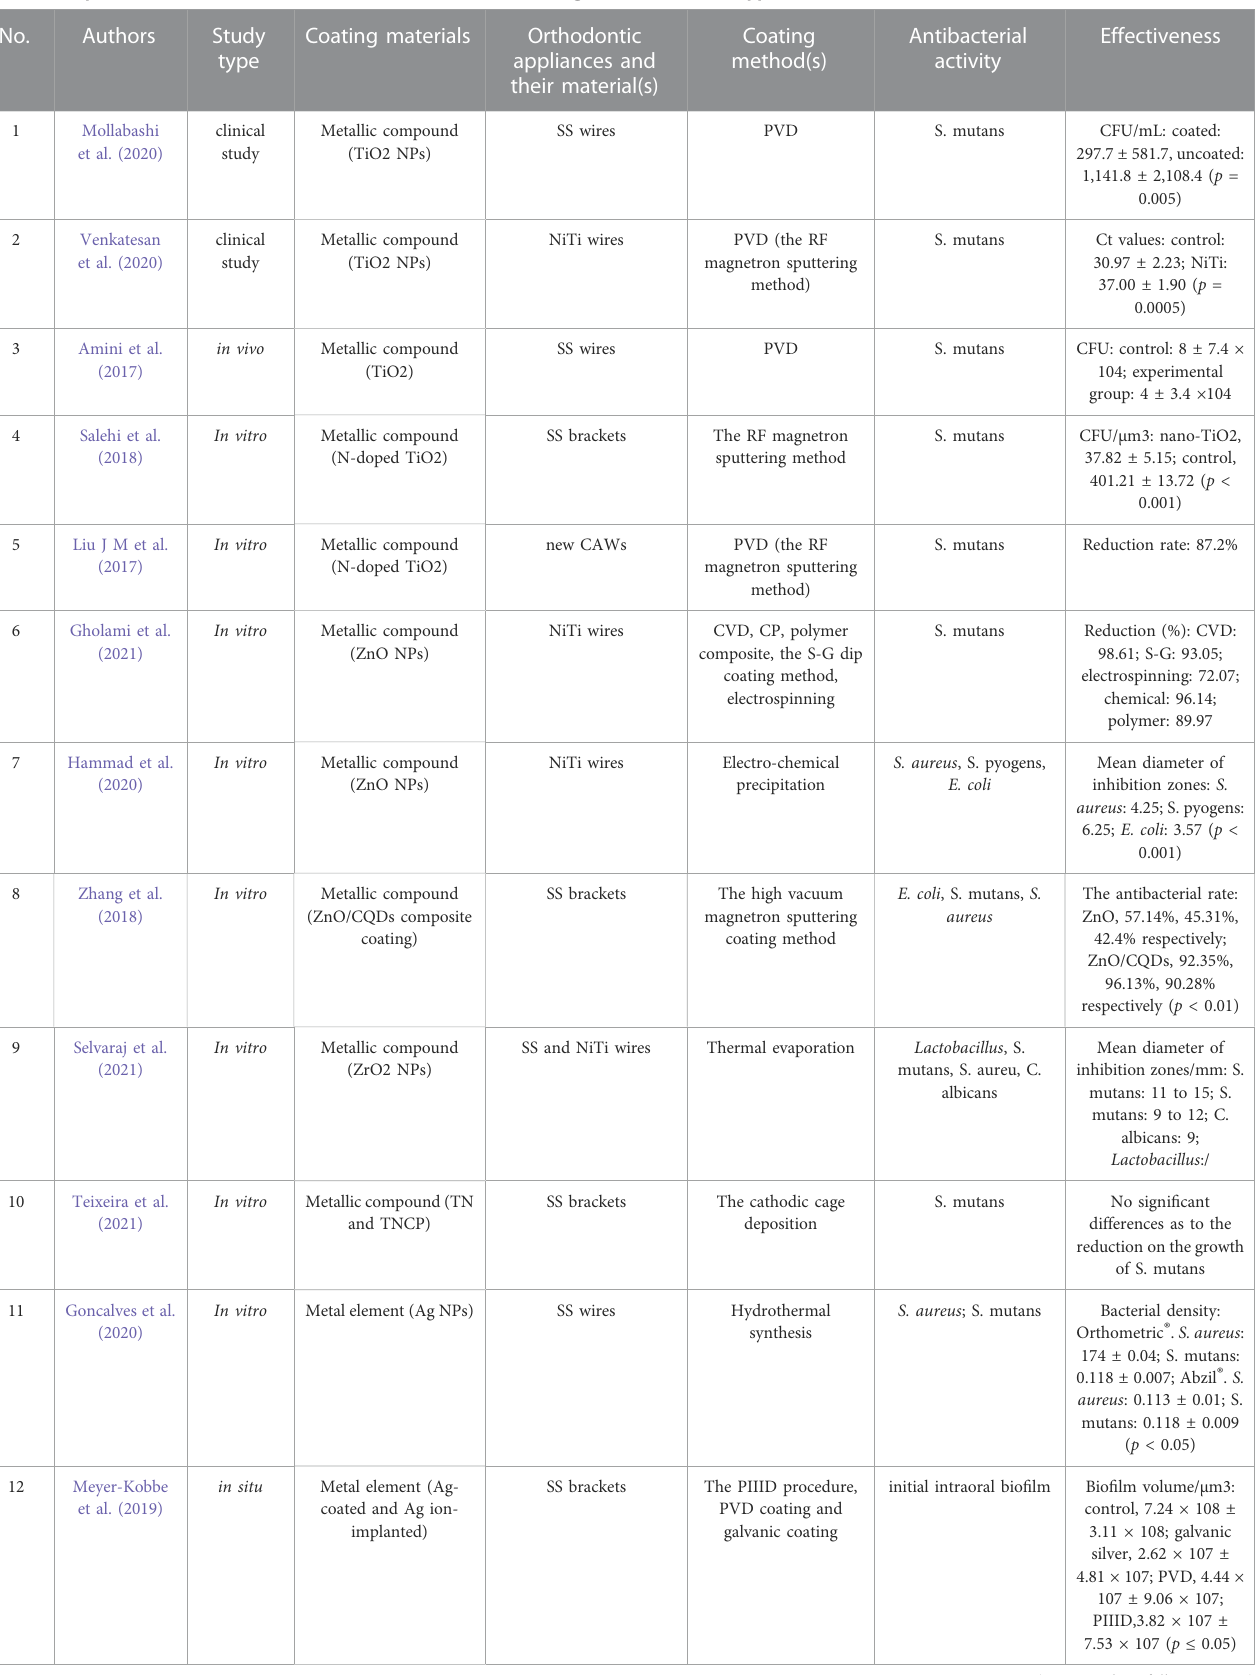
TABLE 1 Comparison of the antibacterial characteristics for different coatings onto orthodontic